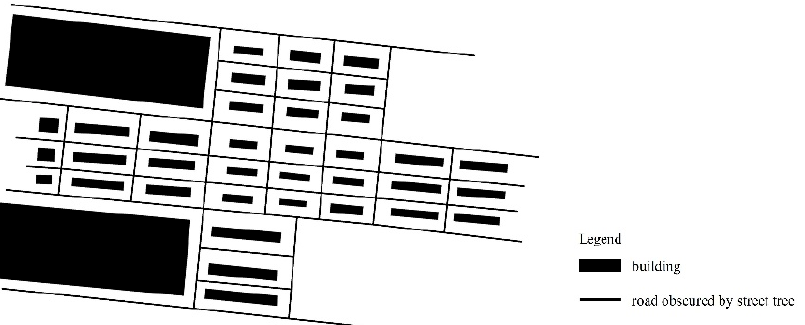
Figure 9. The network structure of street trees.